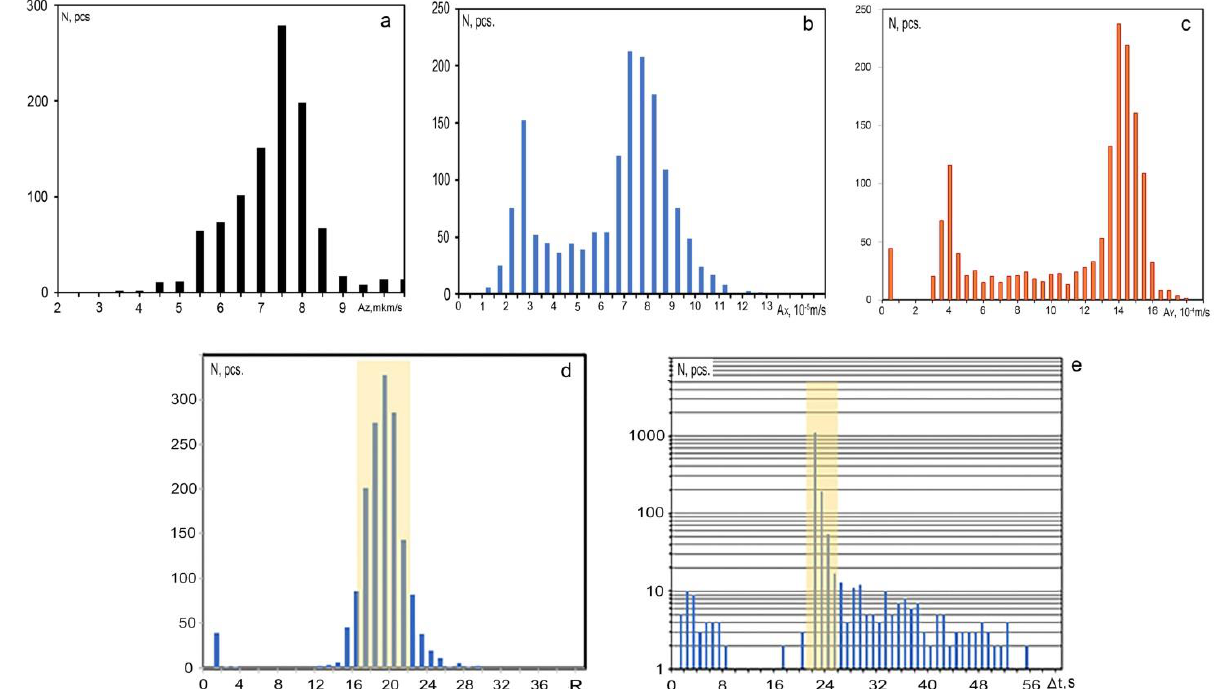
Figure 3. Histograms of the different parameters according to the results of processing for the entire period of observation: amplitude maximums: ( a ) A Z in first arrivals, ( b ) A X for component X , ( c ) A Y for component Y , ( d ) ∆ t , and ( e ) parameter R